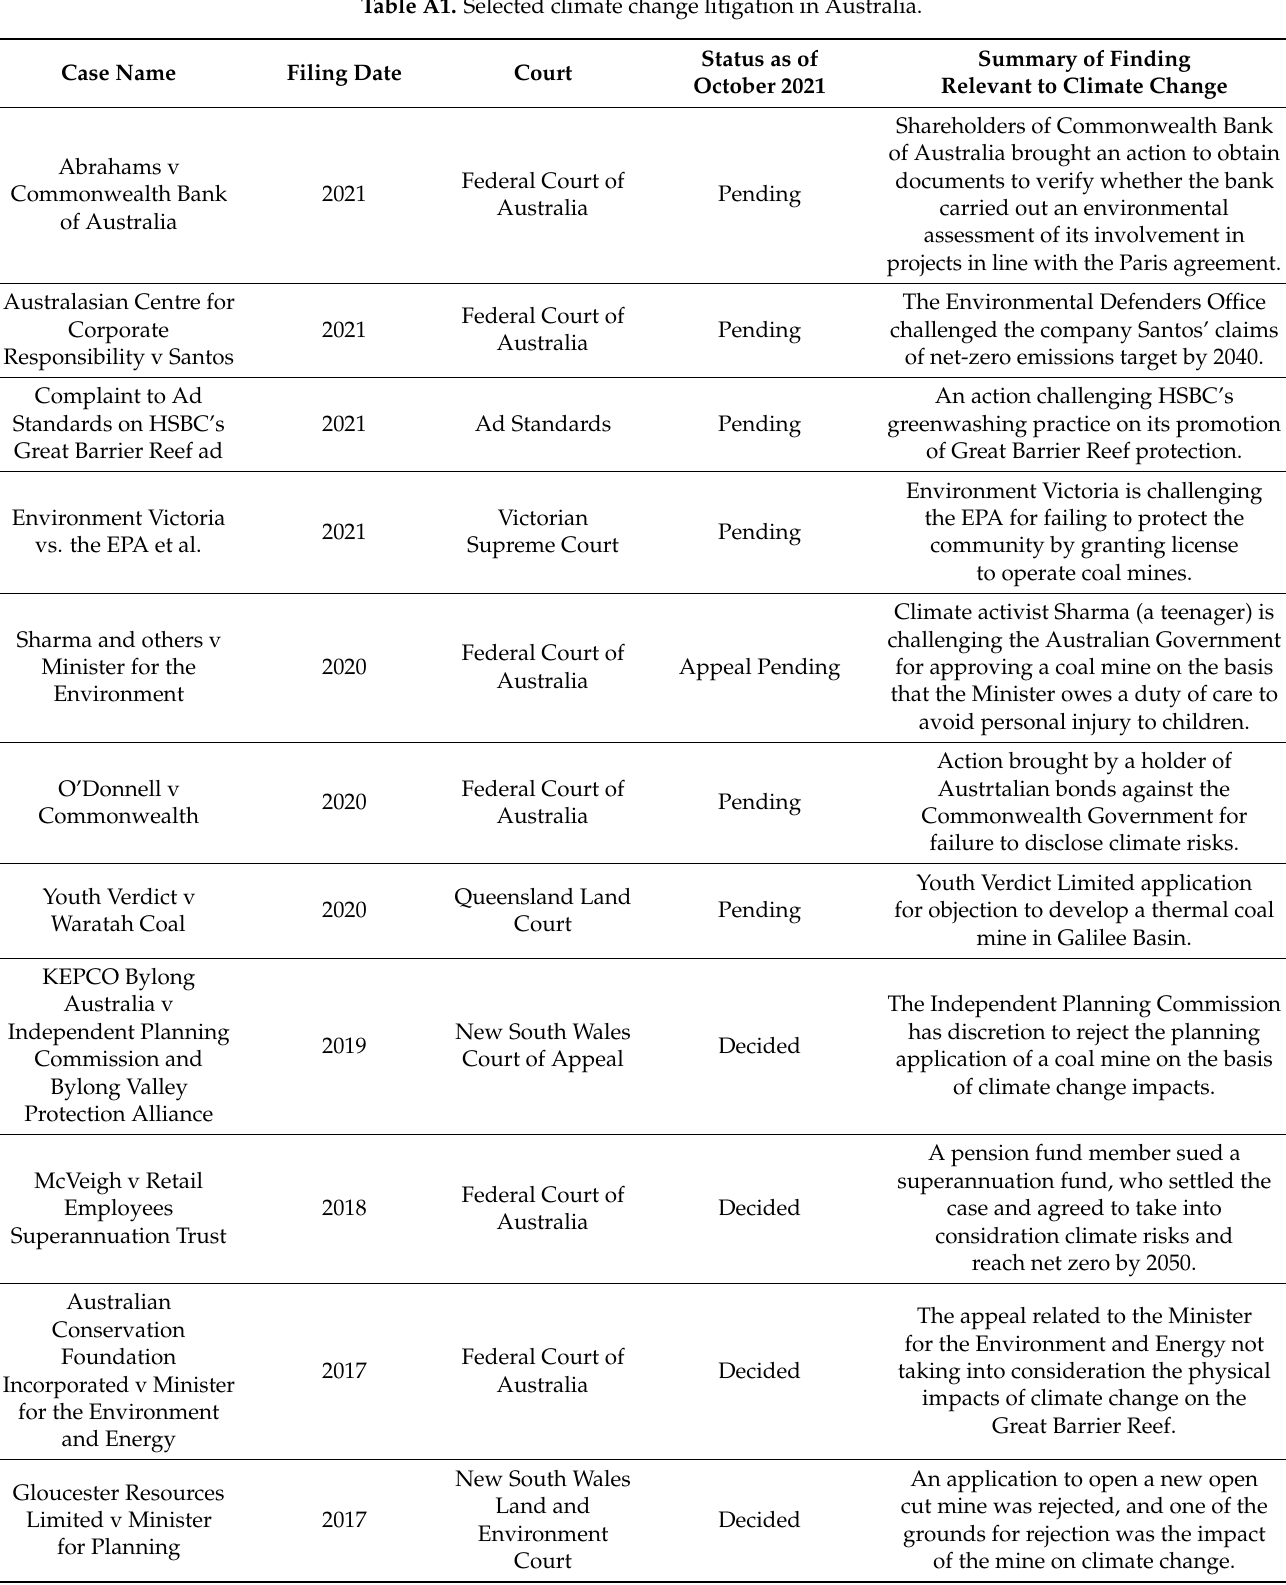
Table A1. Selected climate change litigation in